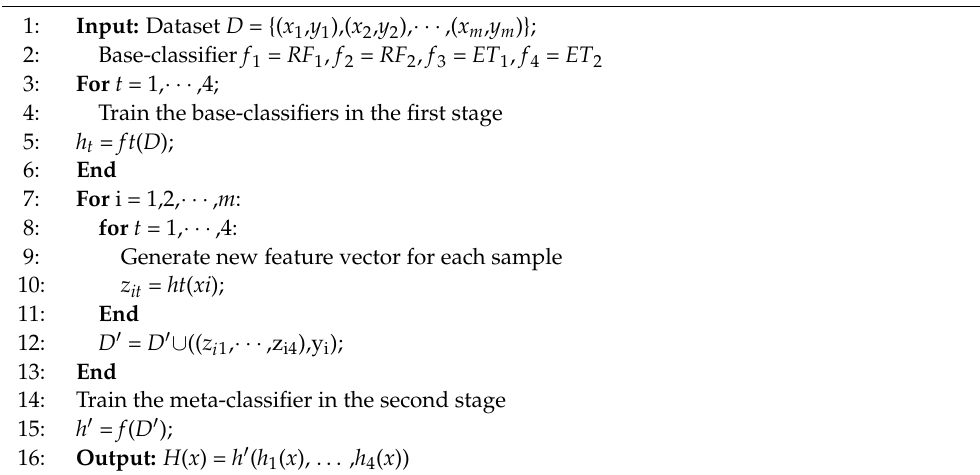
Algorithm A2 Stacked Ensemble Classifier